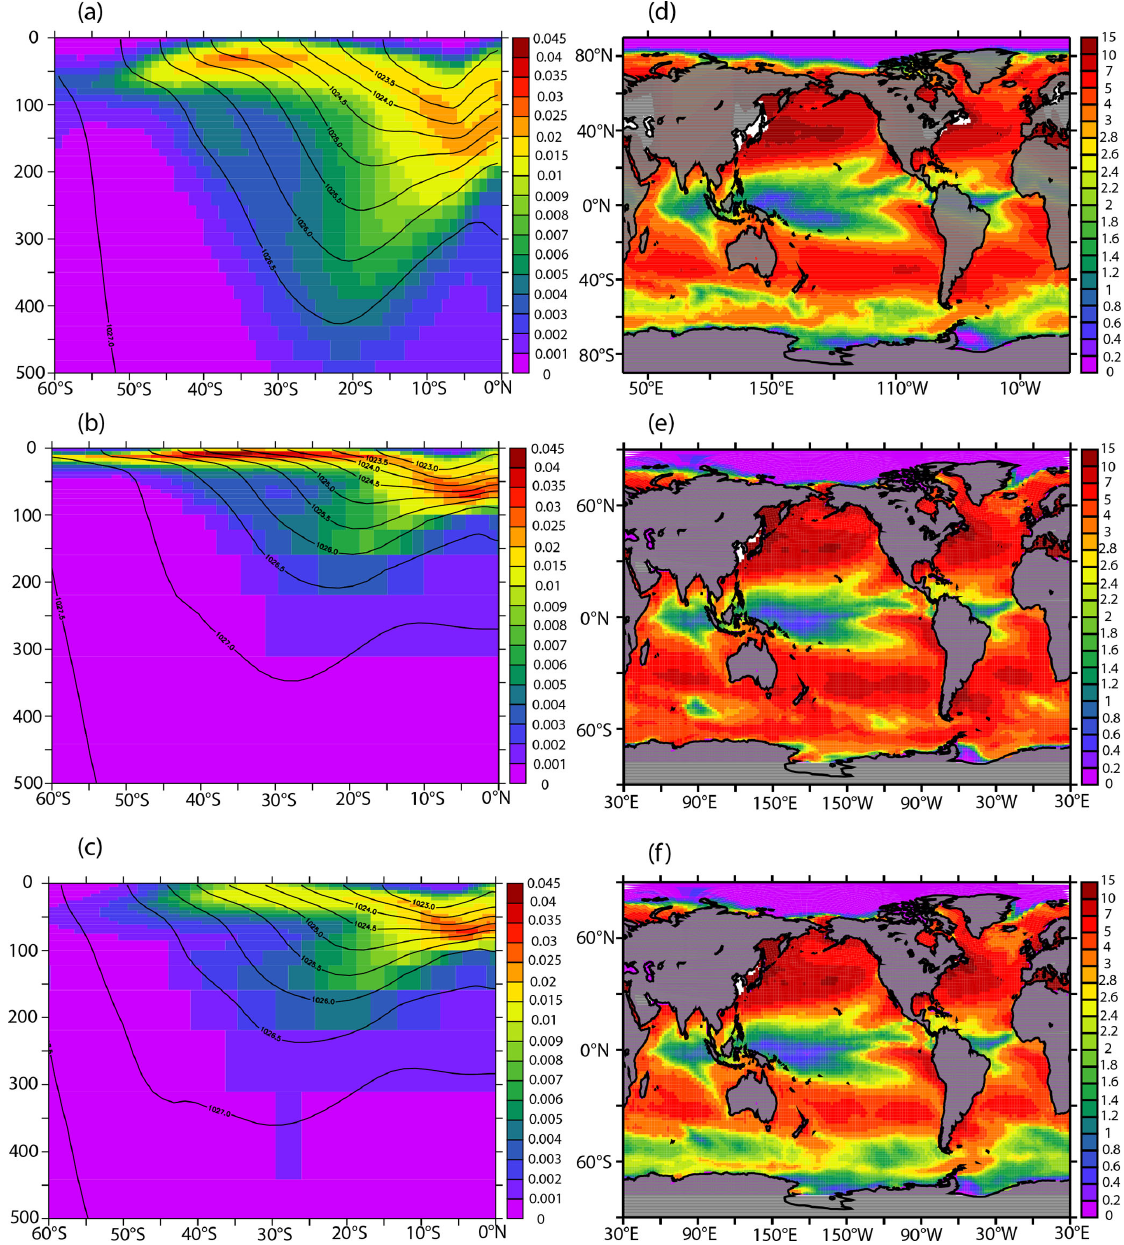
Figure 3. The stratification d ρ 0 / d z (colors) is shown, averaged over the central South Pacific (160 ◦ E–100 ◦ W), for (a) the ARGO-extended data product of de Boyer Montégut et al. (2004), (b) CNTRL, and (c) WSTIR. For each case, potential density contours are overlaid. Also shown is the amplitude of the seasonal cycle of sea surface temperature (SST) ( ◦ C) from (d) the product of Reynolds and Smith (1994) including remote sensing data, (e) for the climatology of the CNTRL run over 2000–2006, and (f) for the climatology of the WSTIR run considered over